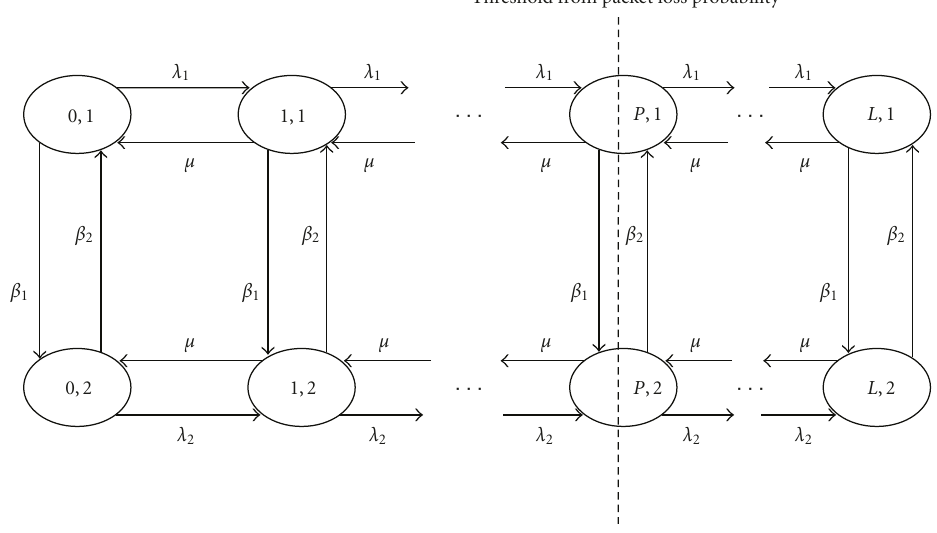
Figure 8: State transition diagramfor each tra ffi c sources ( Q 3 , Q 4 , Q 5 , Q 6 ) under the MMPP-2 arrival process.